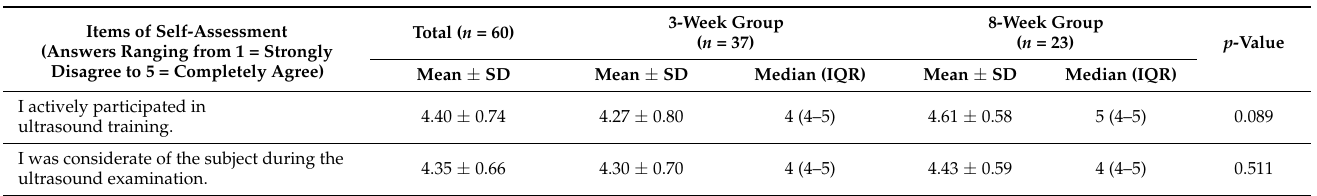
Table 2. Comparison of self-assessment of ultrasound competency and attitude in the 3-week group and 8-week